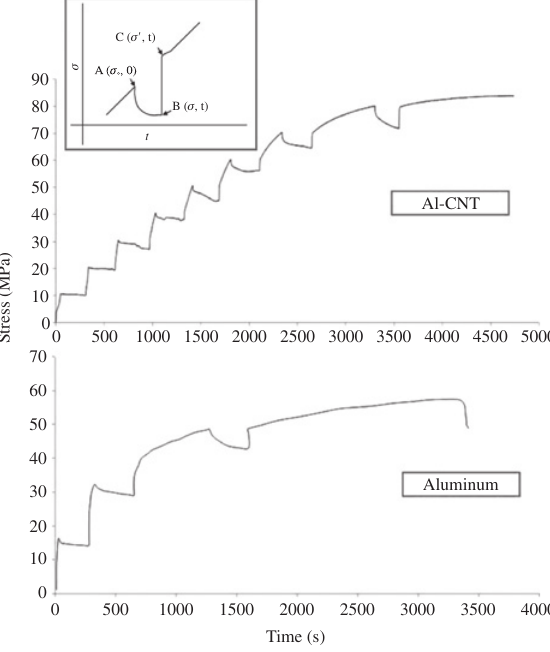
Figure 3: Experimental stress relaxation curves of aluminum and Al-CNT composite. Inset is the schematic of the curve segment during relaxation time.